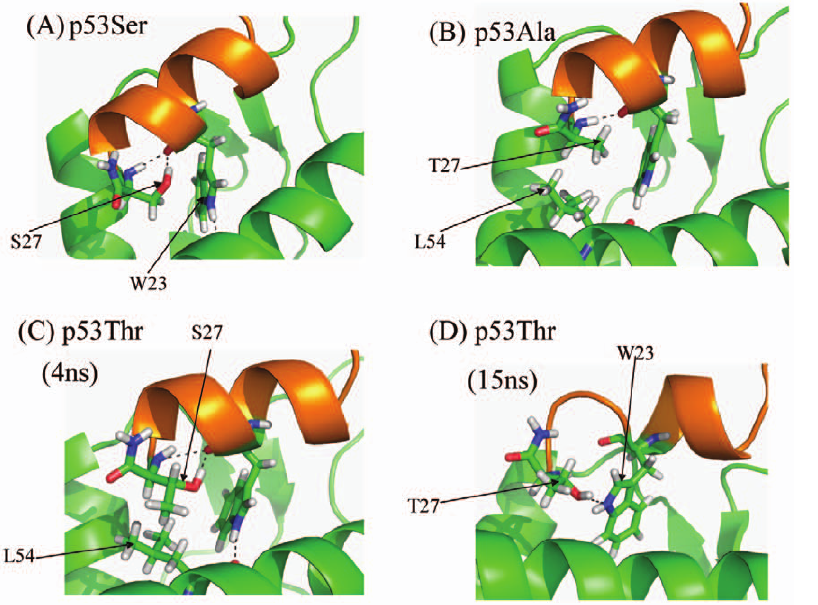
Figure 4. Representative snapshots from the computer simulations of the p53 family based peptides and their interactions with MDM2. Representative snapshots from the trajectories of MDM2 complexed with the p53 mutants: (A) P27S (B) P27A (C) P27T and (D) P27T. Two different snapshots have been shown of P27T to show significantly different interactions.